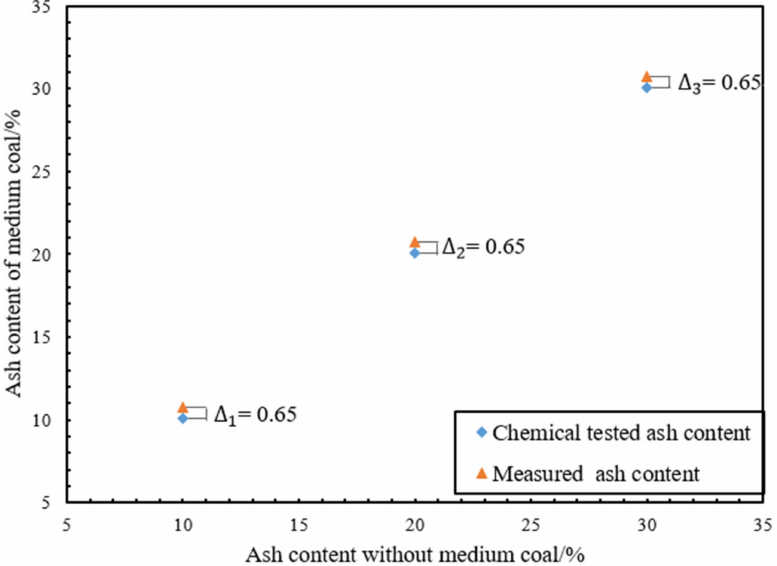
Figure 1. Effect of the medium content ( ε = 1 kg/t) on the measurement result of ash